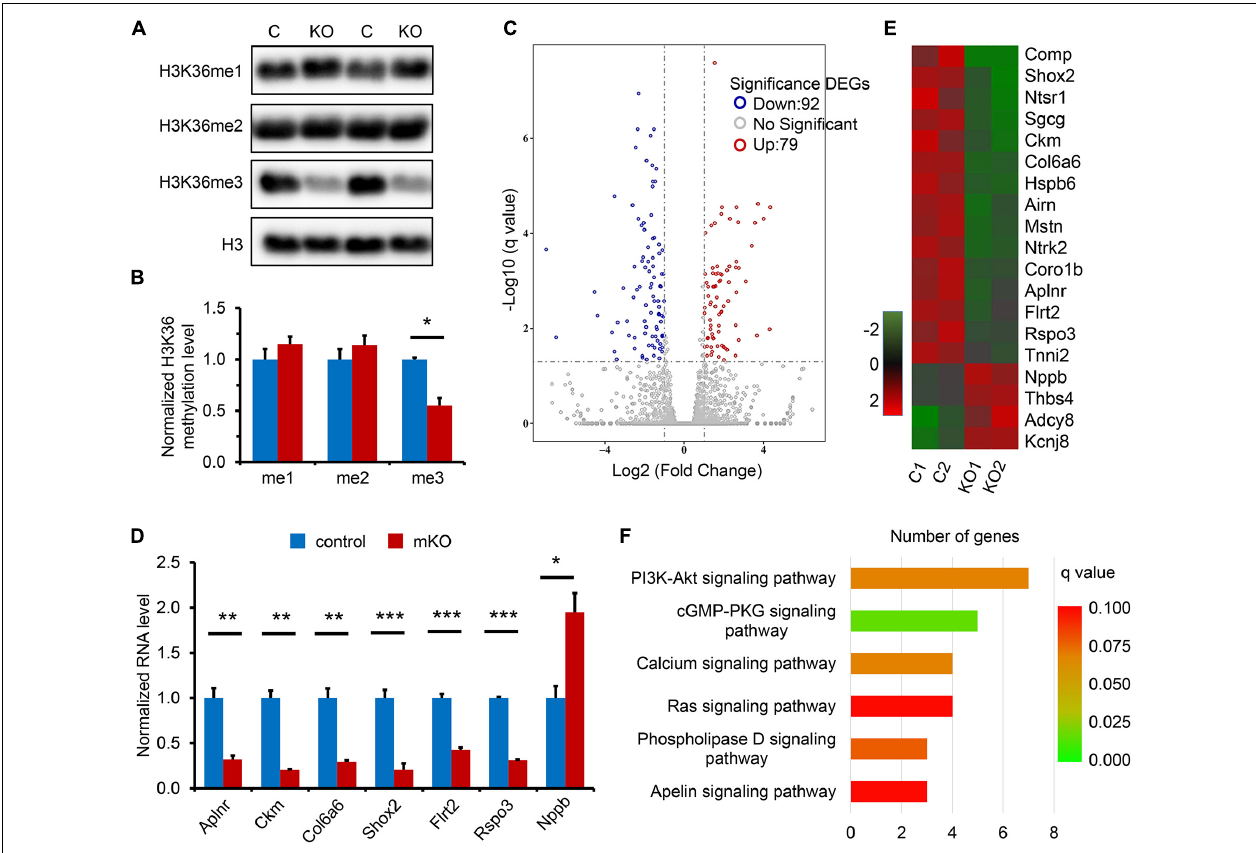
FIGURE 3 | SETD2 regulates H3K36me3 level and downstream gene expression. (A) Western blotting of H3K36me1, H3K36me2, and H3K36me3 levels in control (C) and mKO (KO) hearts at E13.5. Histone 3 (H3) was used as the internal control. (B) Quantification of levels of H3K36me1, H3K36me2, and H3K36me3 normalized to Histone 3. n = 3 for each group. All data represent mean ± SEM. Significance was determined by two-tailed, unpaired Student’s t test. * p < 0.05 versus control. (C) Volcano plot of gene expression in control and mKO hearts at E12.5, indicating that 92 genes (blue circles) were downregulated and 79 genes (red circles) were upregulated in mKO hearts. Log2 fold change ≥ 1 and q value ≤ 0.05 are taken as the threshold. DEGs, differentially expressed genes. (D) RT-qPCR analysis of representative cardiac genes that are downregulated or upregulated by Setd2 deletion. n = 5 for each group. All data represent mean ± SEM. Significance was determined by two-tailed, unpaired Student’s t test. * p < 0.05, ** p < 0.01, *** p < 0.001 versus control. (E) Heatmap of the DEGs that are related to heart development in control and mKO hearts. Two independent experiments are noted as numbers 1 and 2. Color bar indicates relative expression levels. (F) KEGG analysis of the most altered pathways in mKO heart. The horizontal axis represents the number of genes. Color bar indicates q